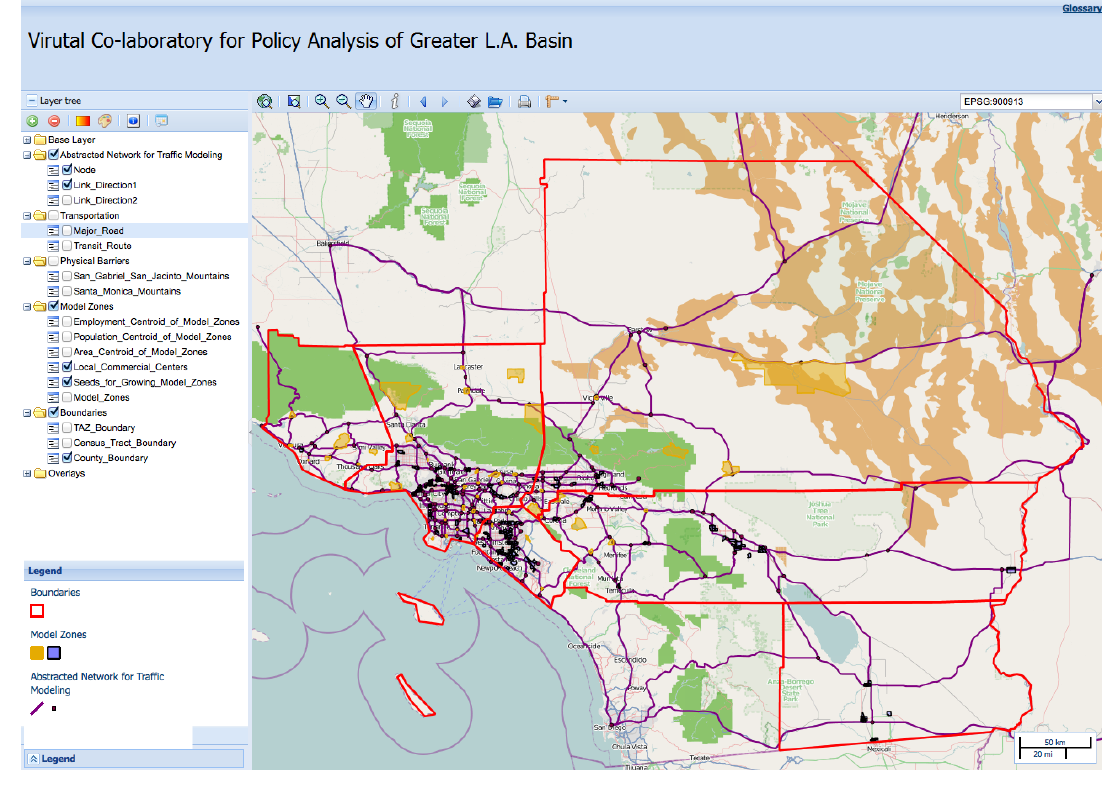
Figure 9. Graphic user interface for the urban GCI